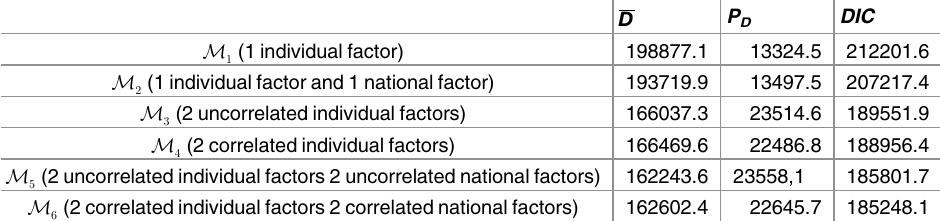
Table 4. Comparison of DIC according to the different